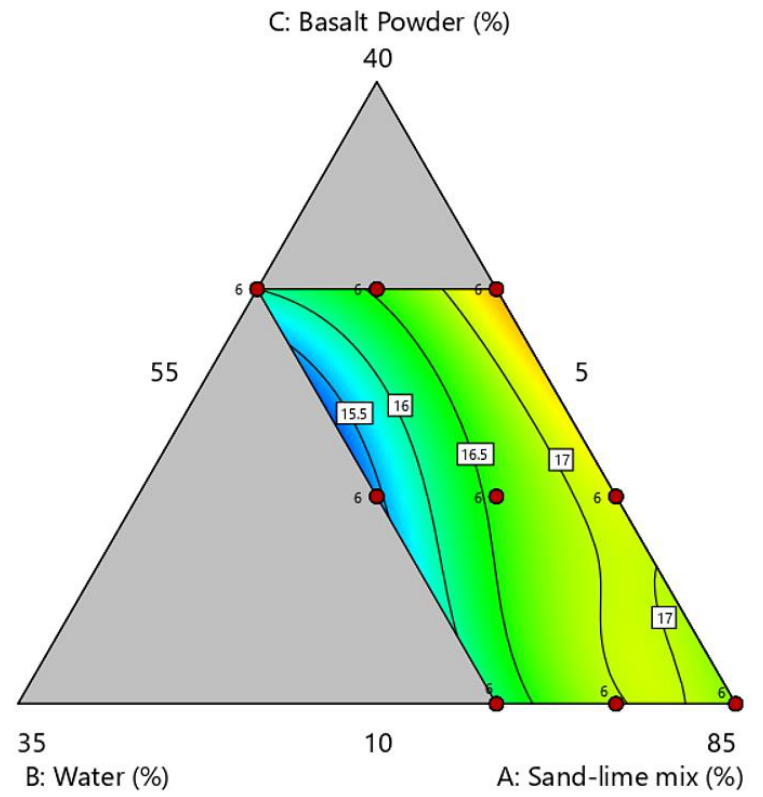
Figure 9. Ternary graph of water absorption.